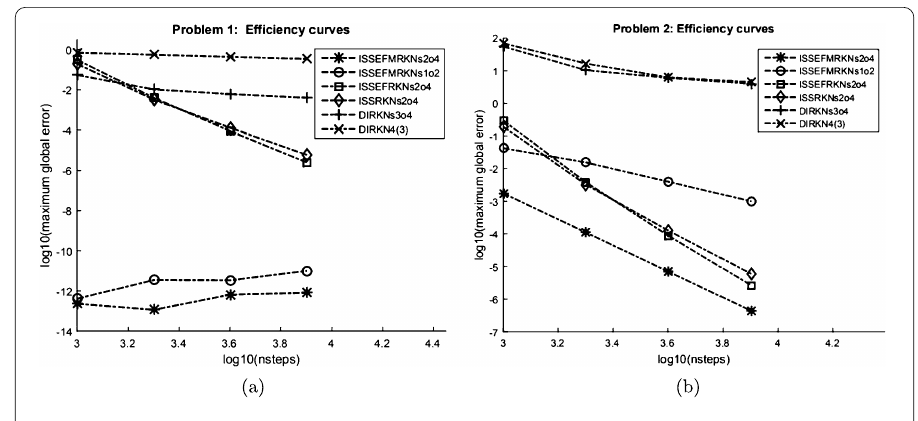
Figure 1 Efficiency curves for solution in ( a ) Problem 1, ( b ) Problem